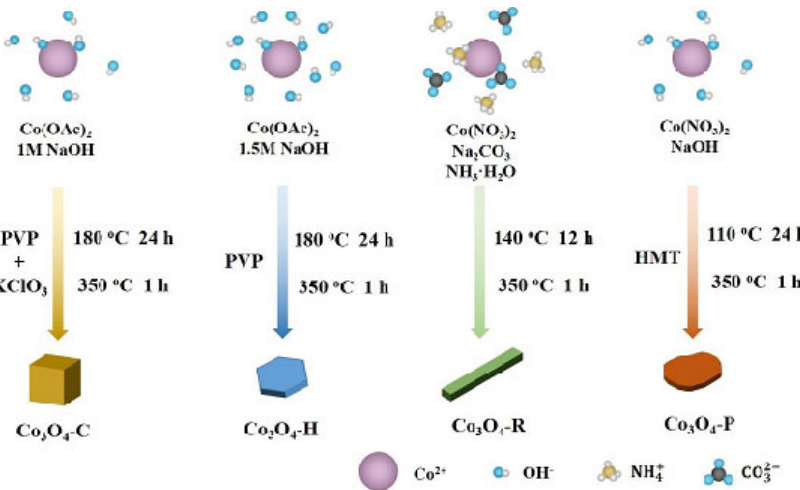
Figure 5. Schematic illustration of the synthetic routes for the investigated Co 3 O 4 catalysts. Reprinted with permission from Ref. [69]. Copyright 2019 John Wiley and Sons.